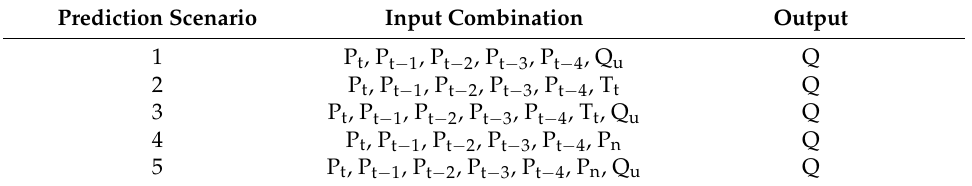
Table 2. ANN model input